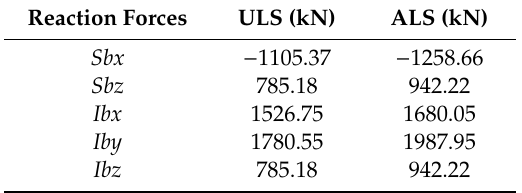
Figure 8. Free-body diagram scheme in the set fairlead/bracket and the reaction forces in the problem. Table 4. Reaction forces calculated in the superior and inferior